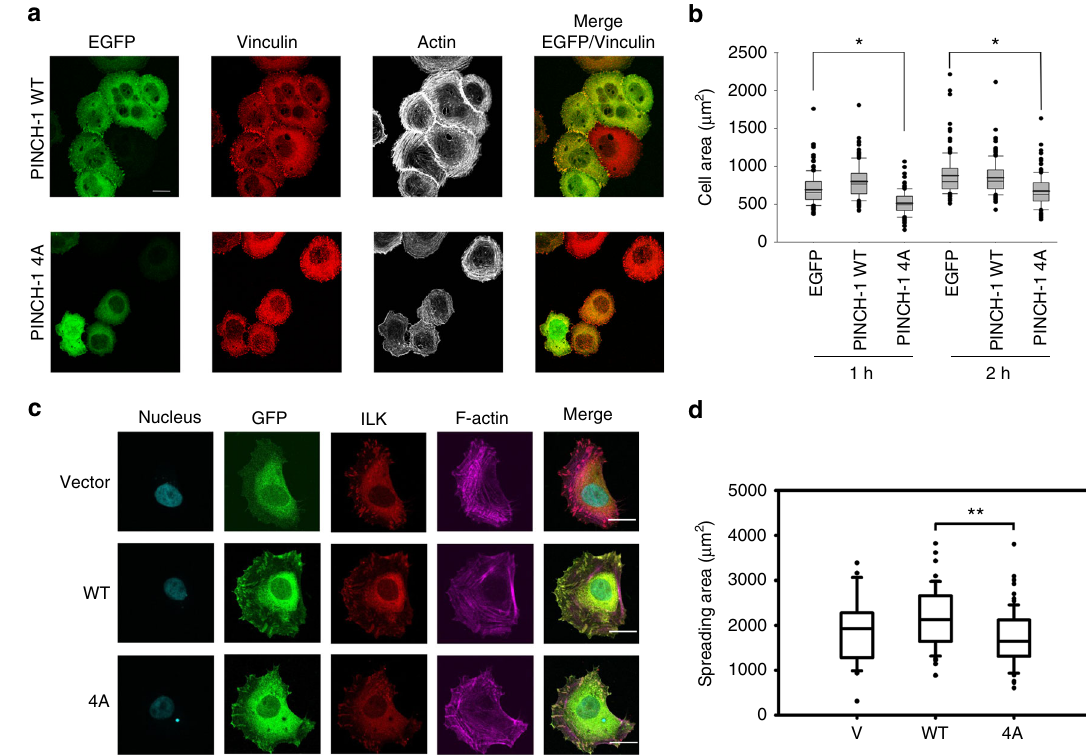
Fig. 5 Cellular defects by PINCH-1 4A mutation. a Overexpression experiment. HEL cells expressing EGFP-PINCH-1 WT or -1 4A cells were stimulated with 800 nM PMA for 10 min, spread on 20 μ g ml − 1 fi brinogen for 1 h, fi xed and stained with Alexa 647-phalloidin to visualize actin and anti-vinculin antibodies to mark FAs. Transfected cells were identi fi ed by EGFP fl uorescence. Top panels. WT EGFP-PINCH-1 promotes the formation of F-actin stress fi bers. By contrast, the stress fi bers were substantially disrupted in the cells expressing the mutant PINCH-1-4A (bottom panels). Scale bar, 10 µ m. b Quantitative analysis of inhibition of cell spreading by PINCH-4A as compared with the WT PINCH-1. Cells were spread on fi brinogen as described in ( a ). The areas of EGFP-positive cells were measured using ImageJ software. * P ≤ 0.001. In total, 150 cells were quanti fi ed in each sample. c CRISPR/Cas9-based knock-in mutation experiment. HeLa clone (2F5) with frame-shifted PINCH deletion mutant, PINCH- Δ C (2F5) was transfected by pEGFP vector (V), pEGFP-PINCH wildtype (WT) or pEGFP-PINCH mutant (4A) and sorted for 2 h spreading on fi bronectin coated coverslips (10 µ g cm − 2 ). Focal adhesions and stress fi bers are clearly disrupted by PINCH 4A mutation. Cells were fi xed and stained for GFP, ILK, and F-actin. Images were then captured with confocal microscope, under 63x magni fi cation. Scale bar, 20 µ m. d Quanti fi cation of cell spreading with physiological level of PINCH WT/4A expression (P1) in HeLa